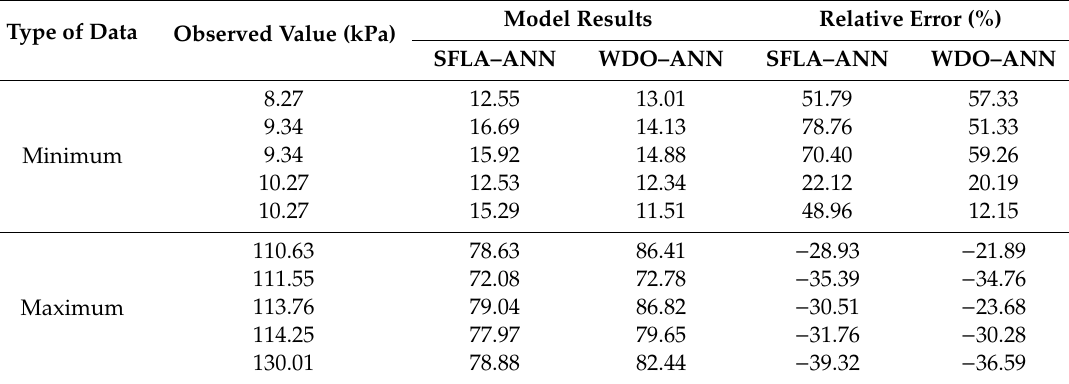
Table 2. Comparison between the SFLA—shu ffl ed frog leaping algorithm and WDO—wind-driven optimization prediction for the maximum and minimum shear strengths